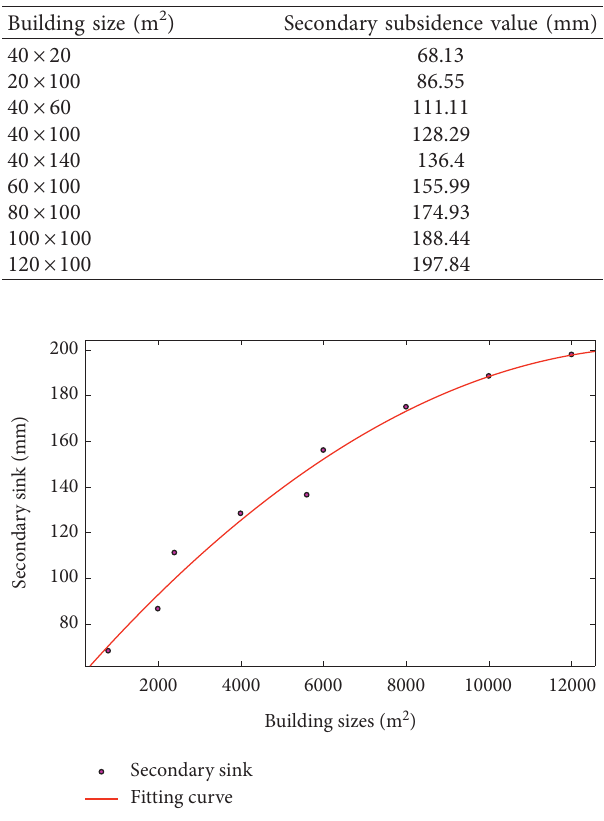
Table 6: Secondary subsidence value with different building sizes.